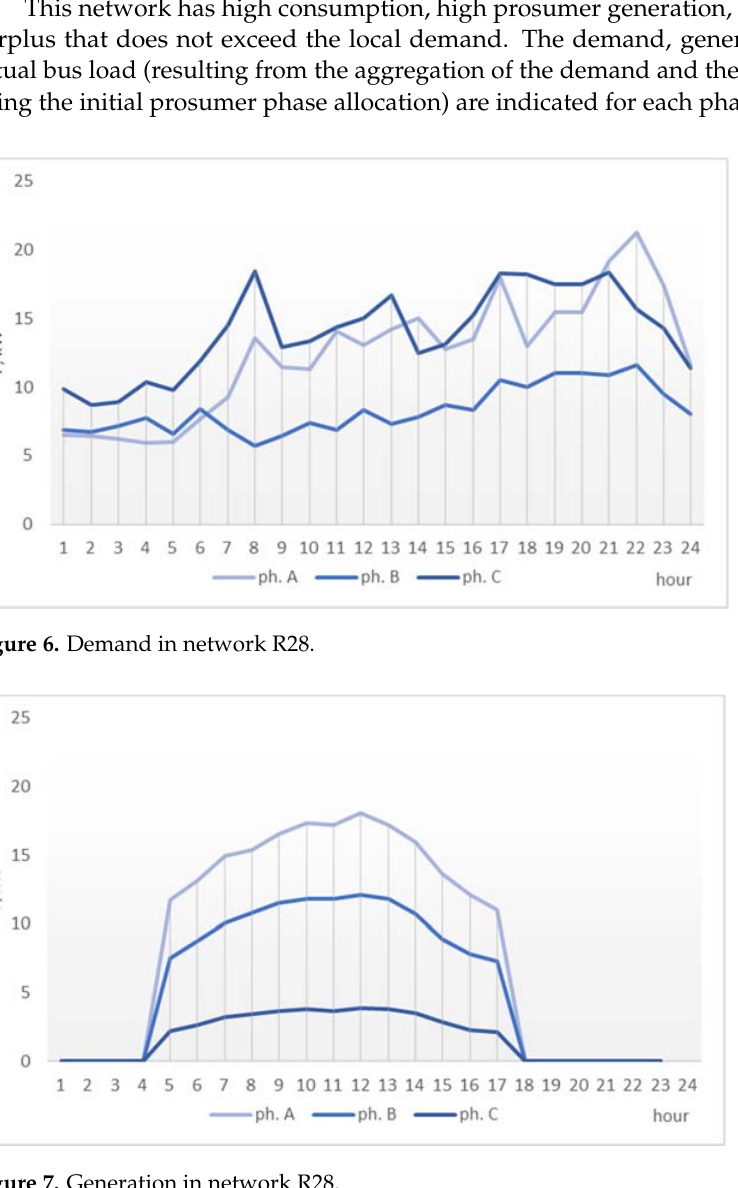
Figure 8. Prosumer surplus in network R28. Figure 9. Actual bus demand in network R28 (aggregated demand and generation). The new phase distribution of the prosumer surplus, in the two optimization scenarios, is presented in Table 3. The results show that, indeed, both methods of shifting the surplus had a positive effect on improving the reduction of power losses by phase load balancing. Using the initial phase connection of the prosumers, given in Table 4, the total active power loss in network R28 was 8.86 kW. By shifting the entire surplus of the